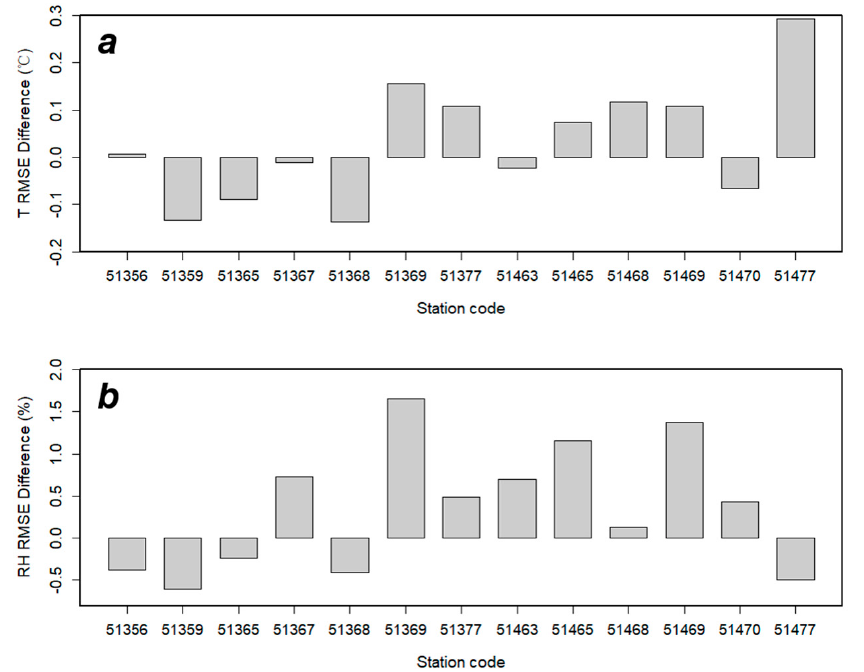
Figure 7. Difference between the RMSE values of post-correction for ( a ) temperature and ( b ) relative humidity by AutoML model fitted by previous month in the same year (2019) and historical data in last year (2018).